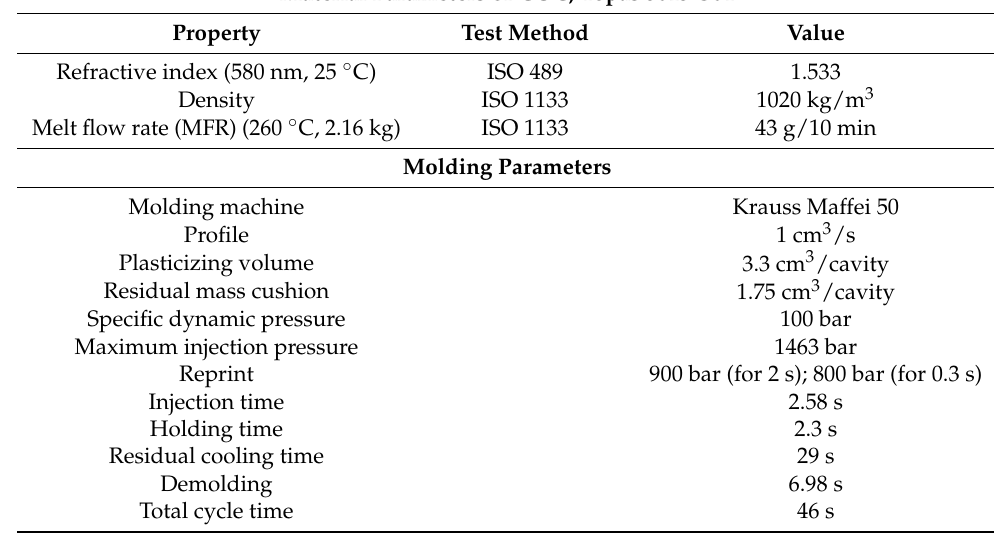
Table 2. Material properties and Process parameters for the micro-injection molding of diffractive structured surfaces.